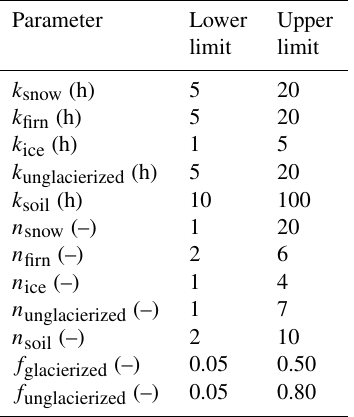
Table 2. Parameter ranges for the runoff module calibration. Parameter Lower